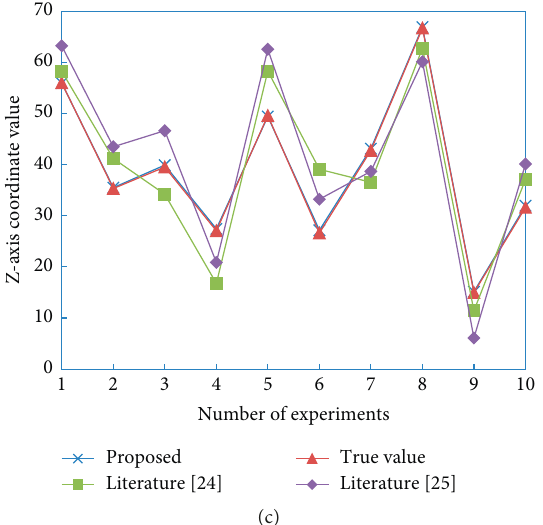
Figure 7: Pose accuracy test. (a) X -axis coordinate value of manipulator. (b) Y -axis coordinate value of manipulator. (c) Z -axis coordinate value of